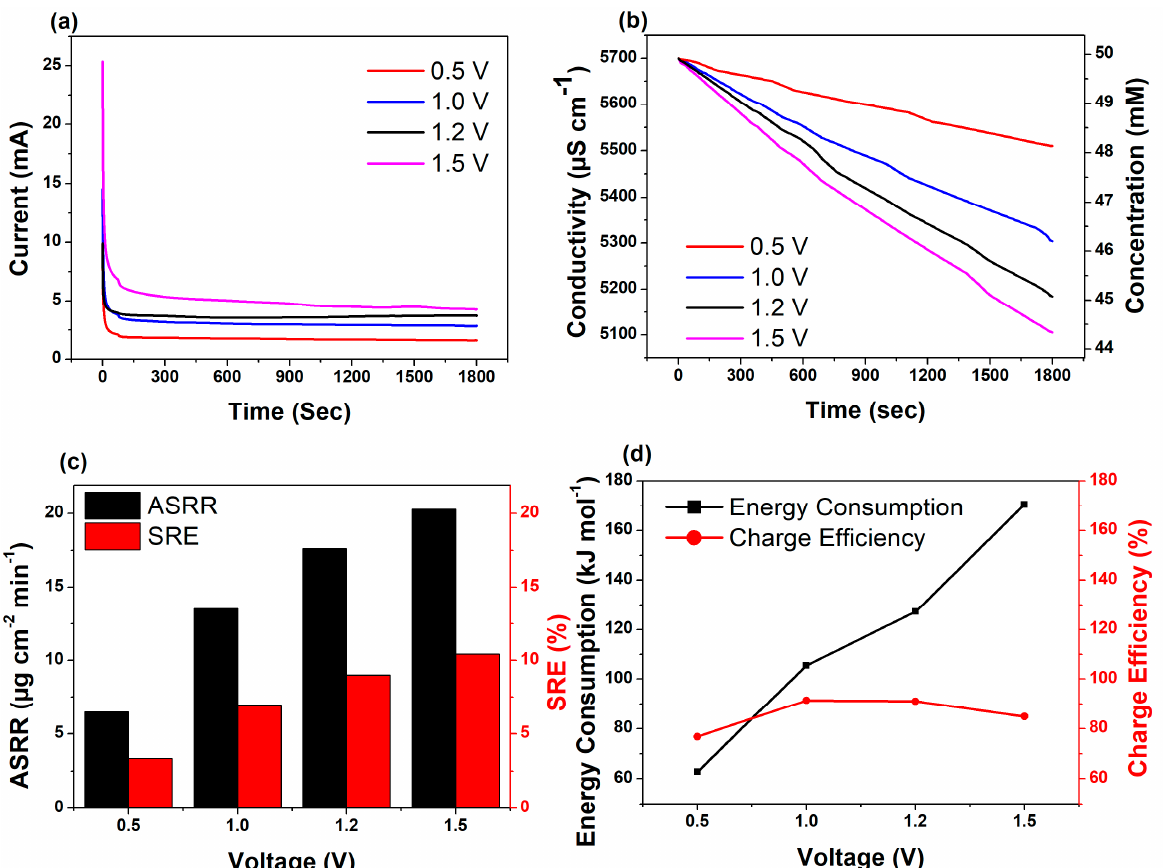
Figure 5. Effect of cell voltage on the FCDI performance: ( a ) I-t curves and the corresponding ( b ) conductivity and saline water concentration changes with time and ( c , d ) determined ASRR, SRE, EC and CE data.